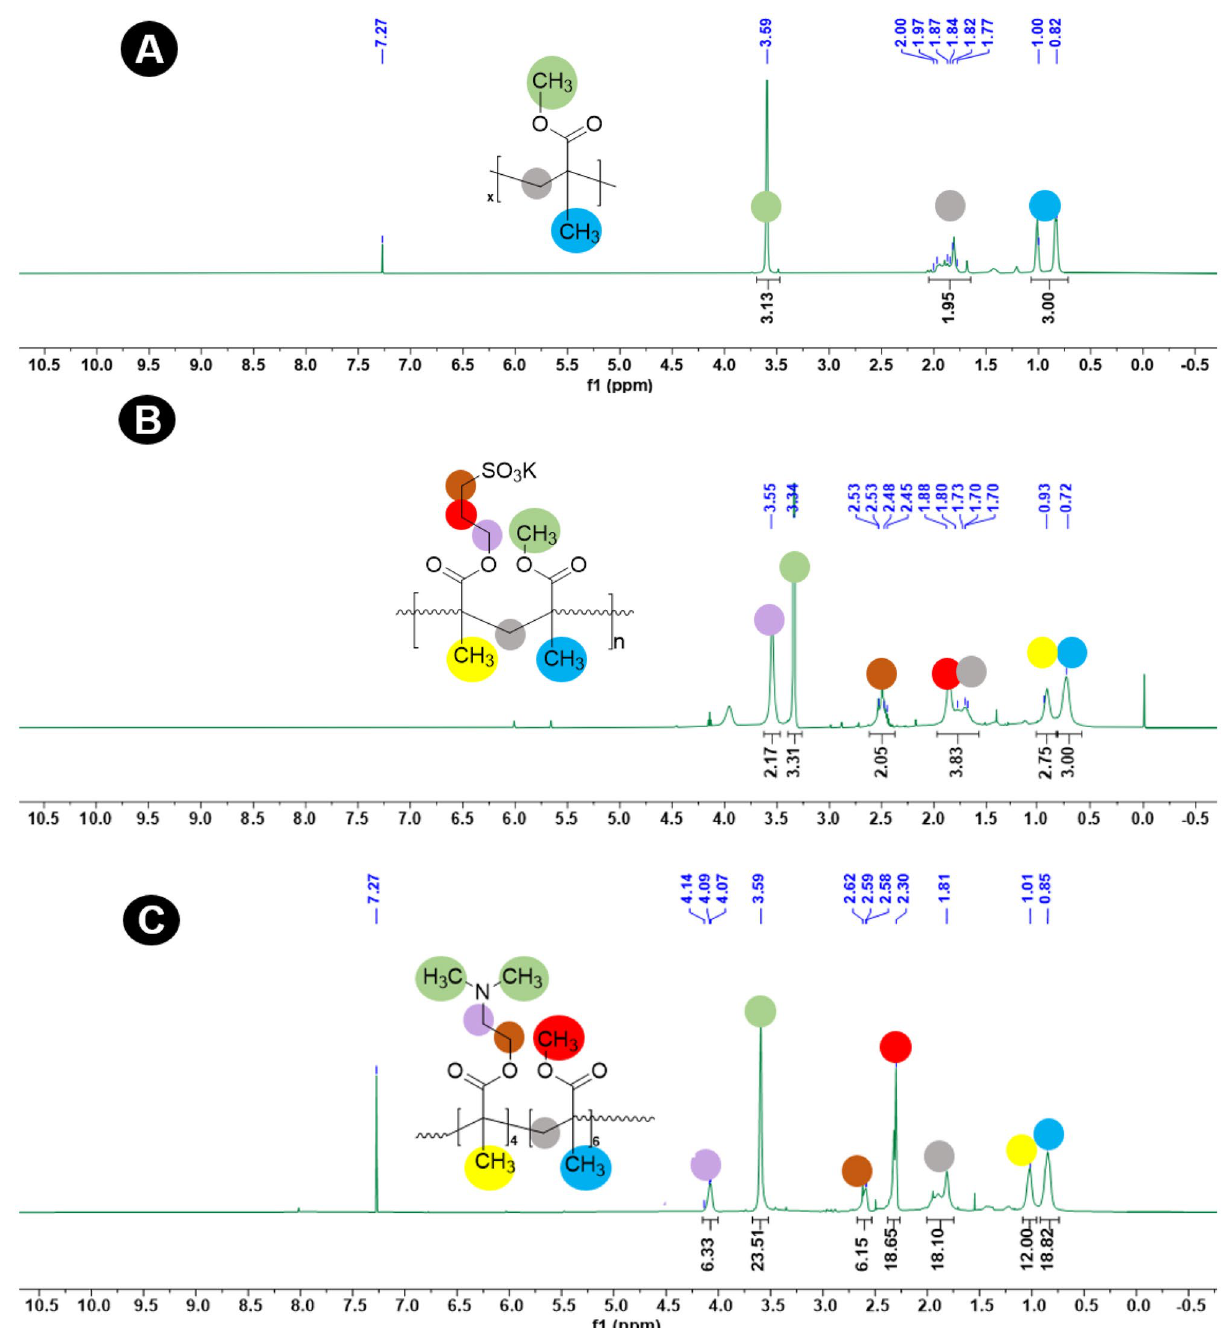
Figure 3. 1 HNMR spectra of polymers: ( A ) p MMA; ( B ) p MD1 and ( C ) p